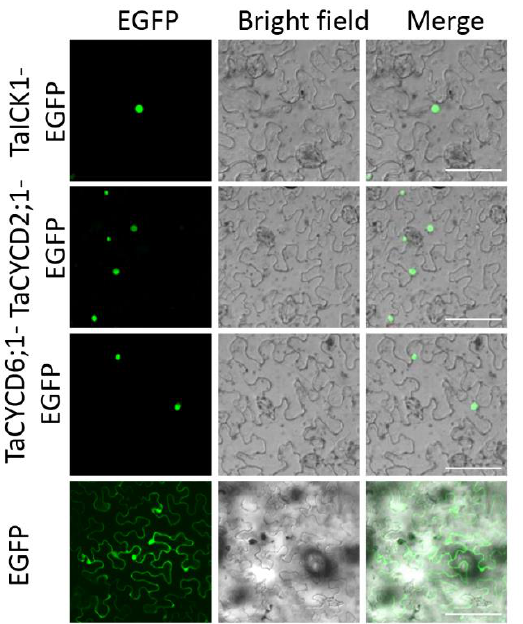
Figure 7. Subcellular localization of TaICK1, TaCYCD2;1, and TaCYCD6;1 in N. benthamiana cells. The fluorescence (EGFP), bright field, and merged images were obtained using a confocal microscope. The scale bars are 50 μm.